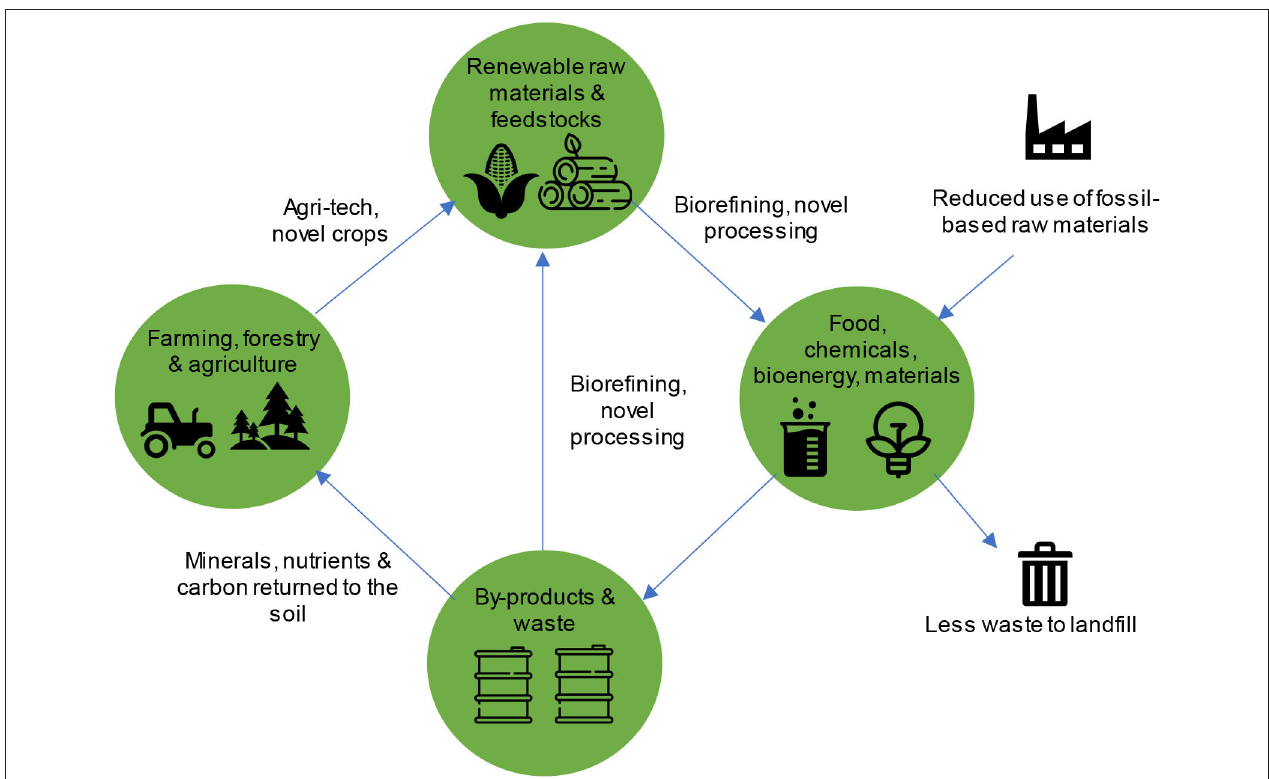
FIGURE 5 | Schematic representation of the concept of